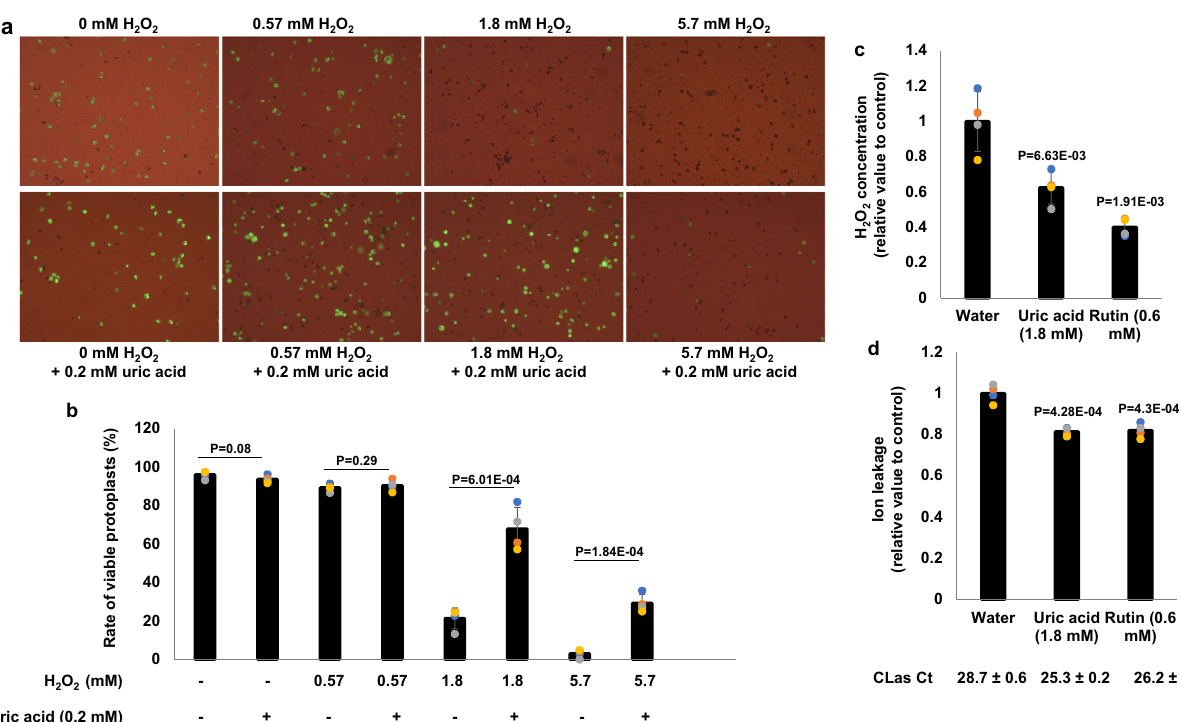
Fig. 5 ROS are responsible for cell death of phloem tissues of CLas-infected citrus. a , b H 2 O 2 kills protoplast cells of C. sinensis . a Freshly prepared protoplast cells of C. sinensis were treated with different concentrations of H 2 O 2 with or without the antioxidant uric acid (0.2 mM) for 24 h and tested for viability via fl uorescein diacetate (FDA) staining. b Quanti fi cation of viable protoplast cells in different treatments of ( a ). c , d HLB-positive plants were treated with antioxidants via foliar spay weekly for 6 weeks. The exudates extracted from phloem-enriched bark tissues were used for detection of H 2 O 2 and ion leakage. d Uric acid (1.8 mM) and rutin (0.6 mM) reduce H 2 O 2 concentration triggered by CLas in the phloem tissue. d Uric acid (1.8 mM) and rutin (0.6 mM) reduce ion leakages in phloem tissues infected by CLas. Statistical differences were analyzed using one way ANOVA with Bonferroni Correction ( P < 0.05). Each experiment contains four biological replicates. Different letters above the columns indicate statistical differences ( P < 0.05). Ct values of CLas of the tested samples were indicated. Source data are provided as a Source Data